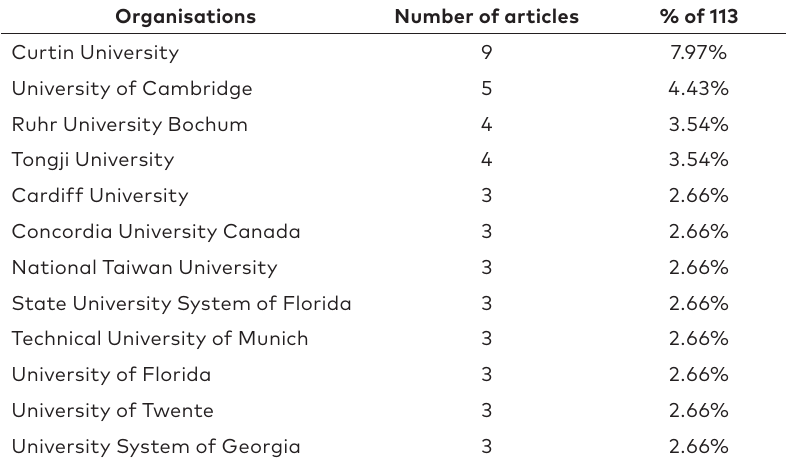
Table 1. The most active